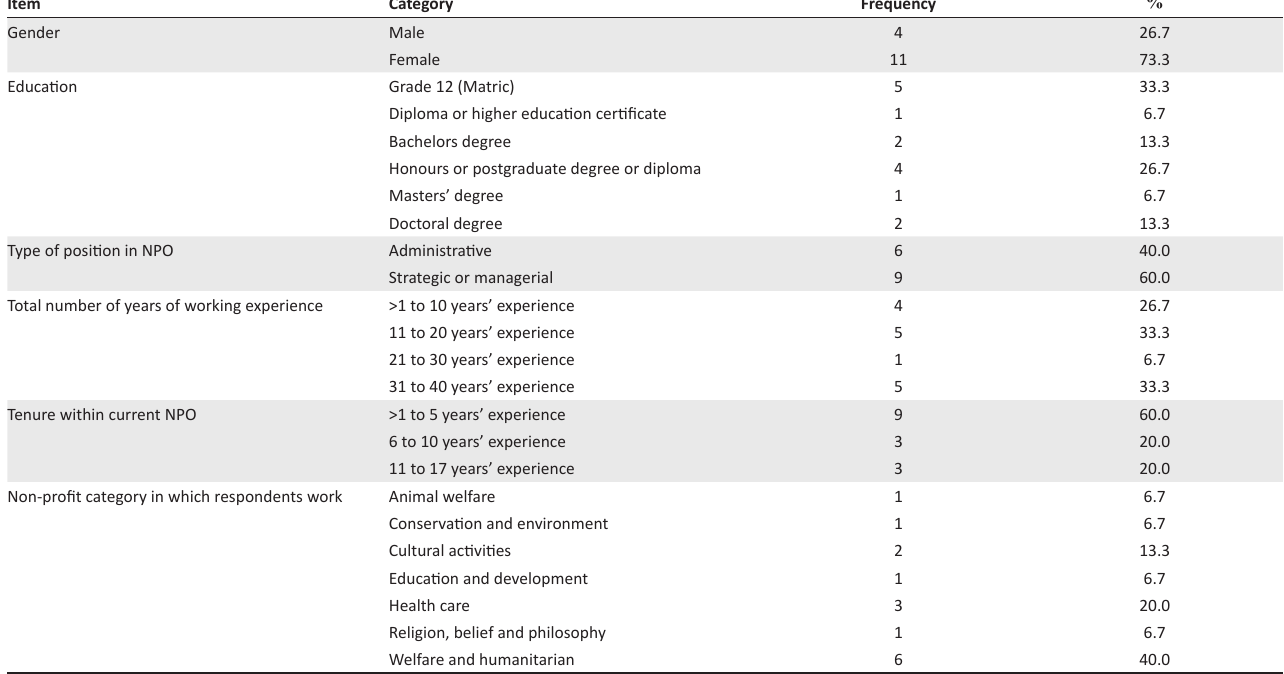
TABLE 1: Frequency distribution of demographic variables ( n =